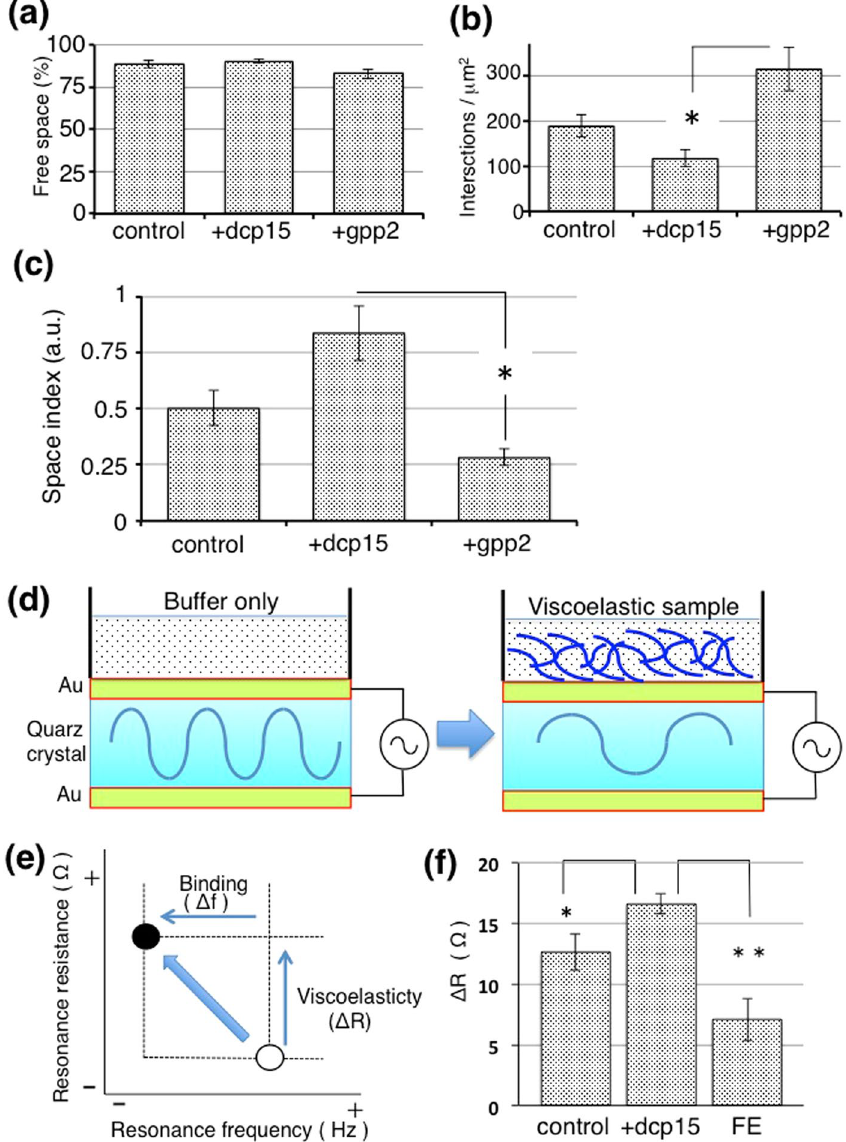
Figure 4. Filament-free area and VE suspension viscoelasticity correlate with fertilization competence. ( a ) To examine the correlation of filament-free area with fertilization competence, we first measured the ratio of filament-free area against the total area (mean ± SEM, n = 4). ( b ) The number of intersections per area was measured (mean ± SEM; * P = 0.008, Student’s t -test, n = 4). ( c ) The ratio of free-space/number of intersection (mean ± SEM; * P = 0.008, Student’s t -test, n = 4). Filament-surrounded free space of fertilization competent VE is significantly smaller than that of fertilization incompetent VE (mean ± SEM; * p = 0.04, Student’s t -test, n = 30), suggesting that fertilization competence is correlated with the filament-surrounded free space. ( d ) A scheme that represents QCM analysis. Alternating voltage induces the oscillation of the quartz crystal. When a supension of viscous VE is placed on the surface of the quartz crystal, the resonance properties of the quartz oscillation change. ( e ) A scheme that represents changes in parameters at QCM analysis. Viscous sample evokes an increase in resonance resistance (dR) and a decrease in frequency (df), each of which reflects the viscoelasticity, and the binding to the quartz surface, respectively. ( f ) Fertilization competence-dependent changes in resonance resistances. Increases in resonance resistance were averaged (mean ± SEM; * P = 0.03, ** P = 0.005, Student’s t -test, n = 6–10). Dcp15-treated incompetent VE showed a greater resistance ( i.e ., greater viscoelasticity) than the control VE, indicating that dicalcin increased the viscoelasticity of the VE. In addition, the FE showed a lower resistance than control, indicating that FE has lower viscoelasticity. Thus, viscoelasticity for successful fertilization resides within a limited range between the iVE and FE values ( i.e ., 7.5–16